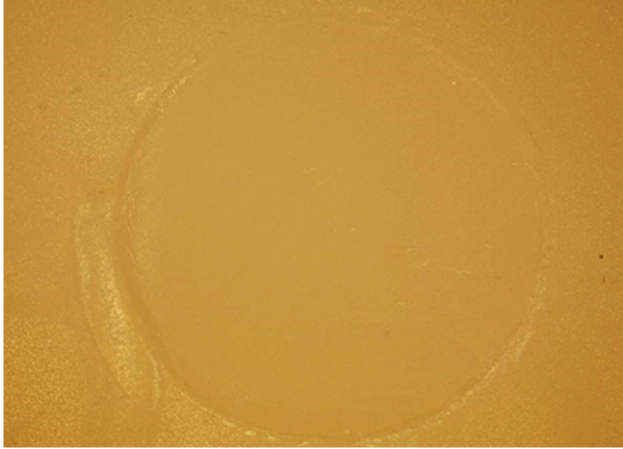
Figure 3. Representative image (optical microscope x10) of a mixed failure.